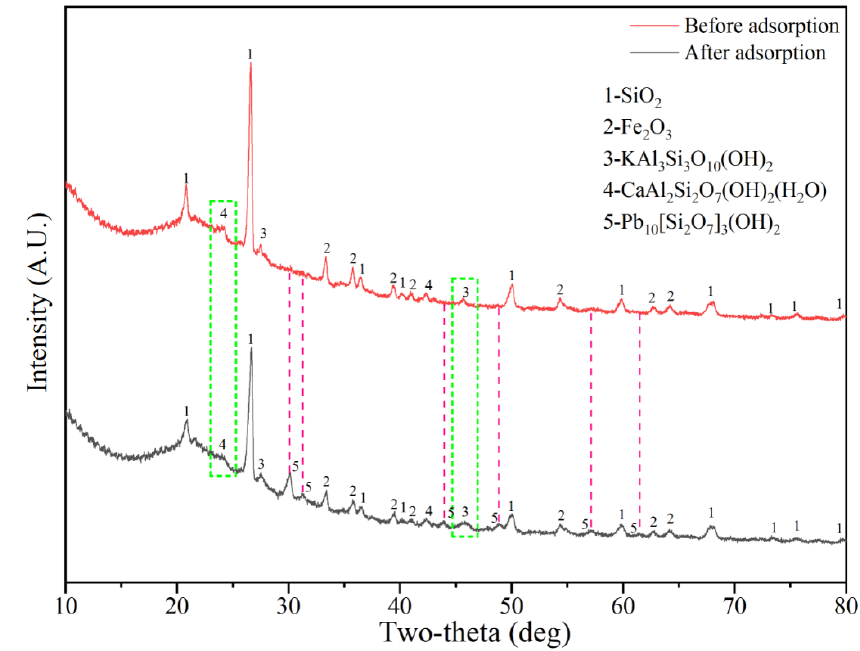
Figure 8. XRD analysis before and after